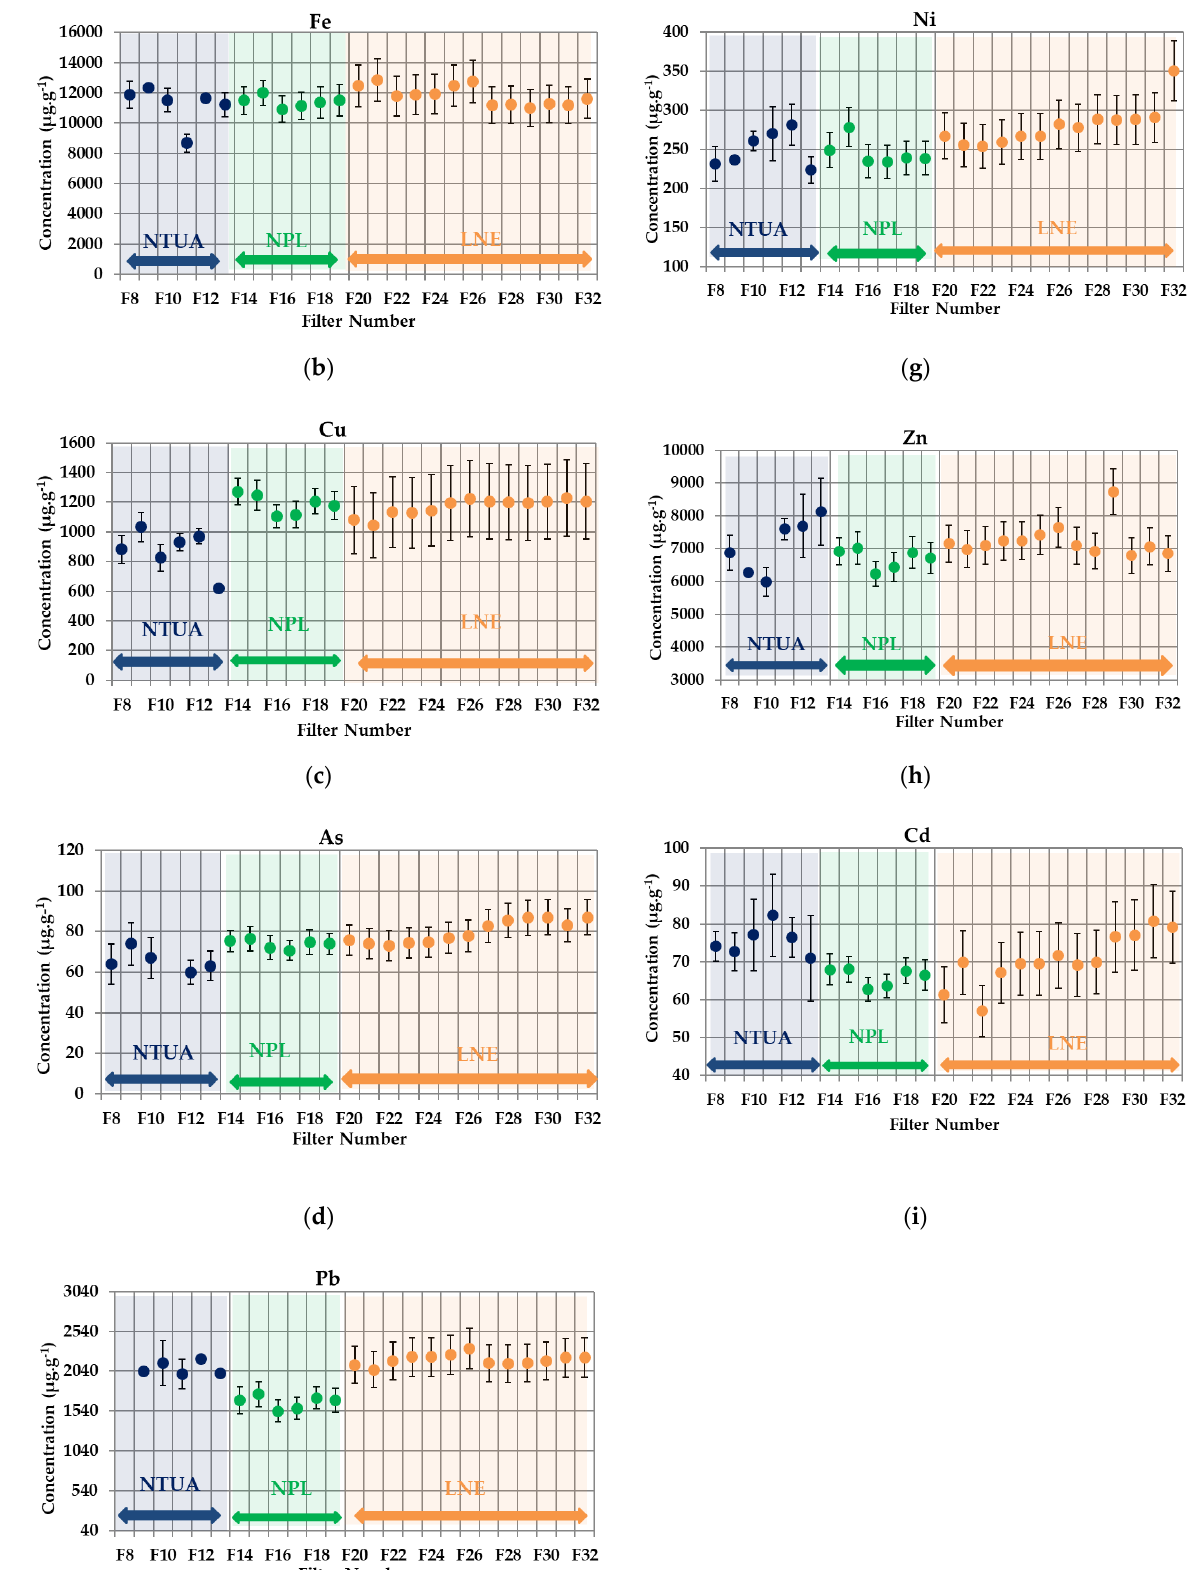
Figure 3. Inductively Coupled Plasma–Mass Spectrometry (ICP-MS) intercomparison results for particulate matter PM 10 - loaded filters. ( a ) Cr, ( b ) Fe, ( c ) Cu, ( d ) As, ( e ) Pb, ( f ) Mn, ( g ) Ni, ( h ) Zn and ( i )